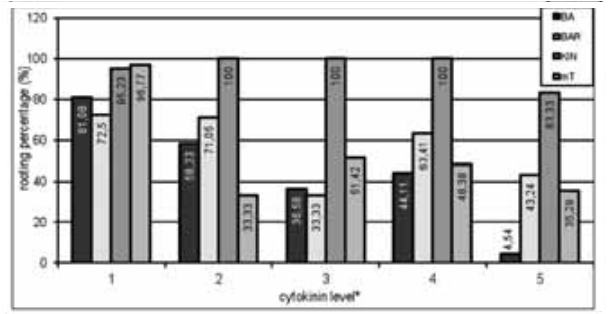
Figure 6. Rooting percentages of in vitro Nidularium ’Kertész Jubileum’ plants cultured on different kind of medium (*cytokinin levels were shown on Table 1 )